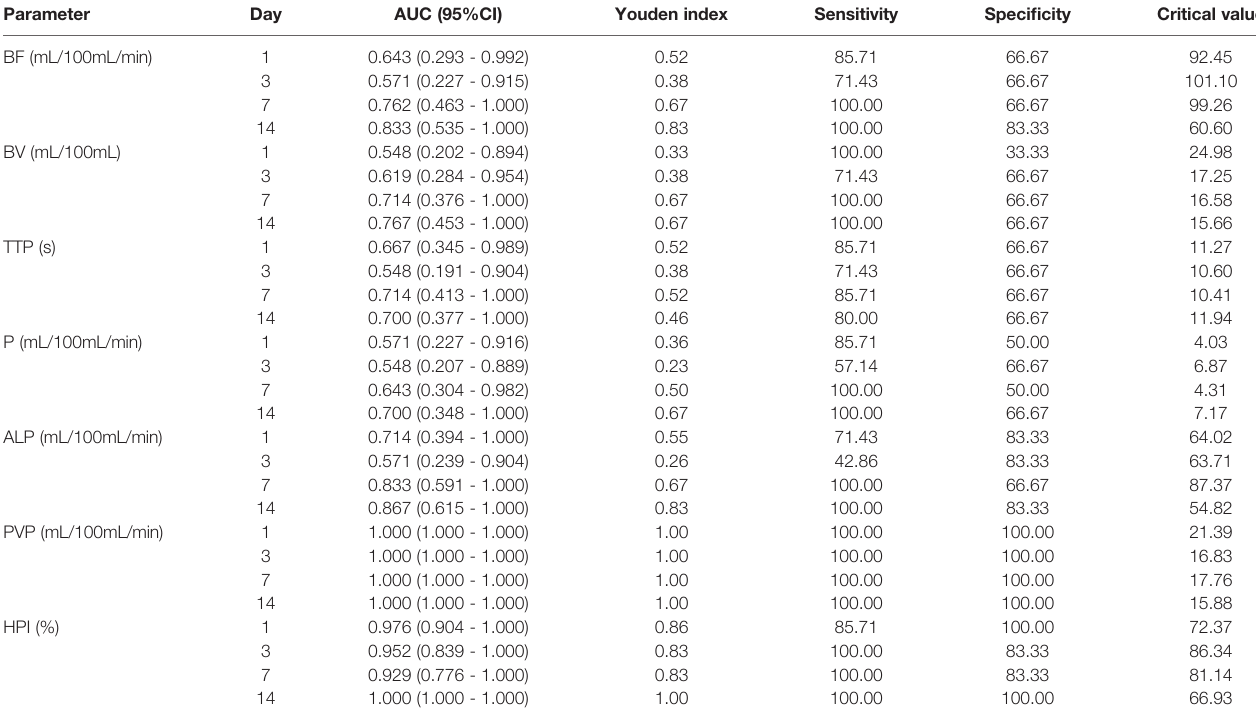
TABLE 3 | Diagnostic performance of each parameter of CT perfusion in distinction of viable tumor and BPE. Parameter